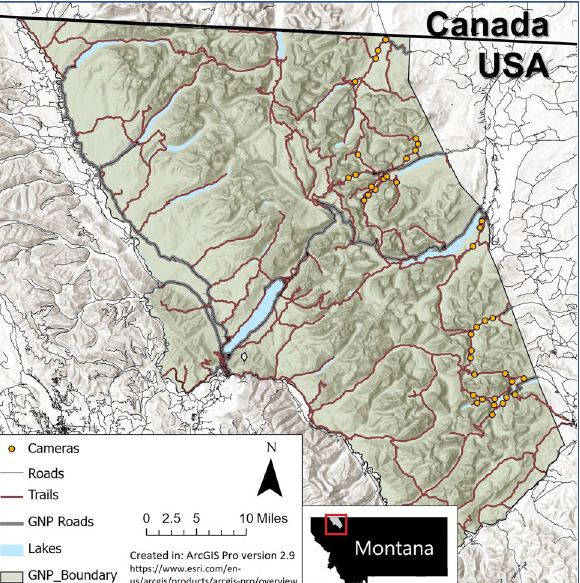
Figure 1. Camera locations on the eastern side of Glacier National Park, Montana. Cameras were located in the exact same location, and run during the same days, during a park closure with no recreation and when the park was open to recreation. Map made using ArcGIS Pro version 2.9 (https:// www. esri. com/ en- us/ arcgis/ produ cts/ arcgis- pro/ overv